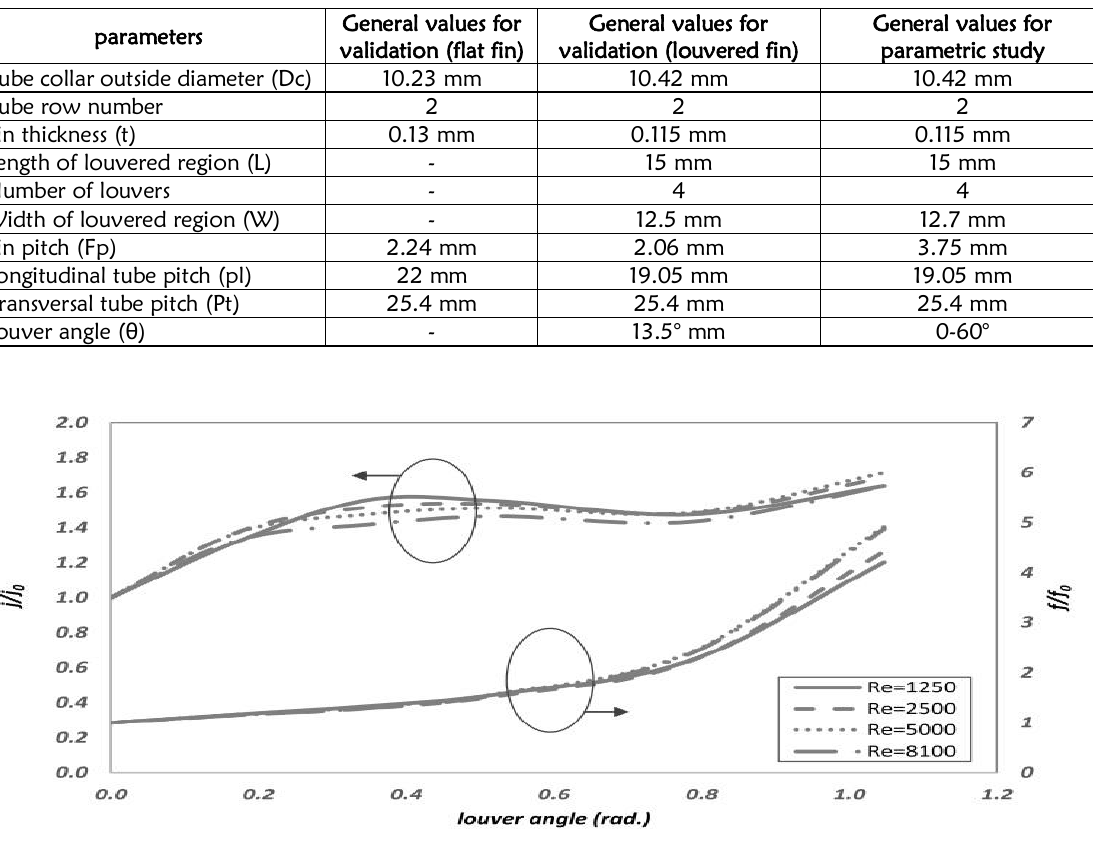
Figure 4: Effect of Reynolds number on parameters j/j0 and f/f0 in different louver angles